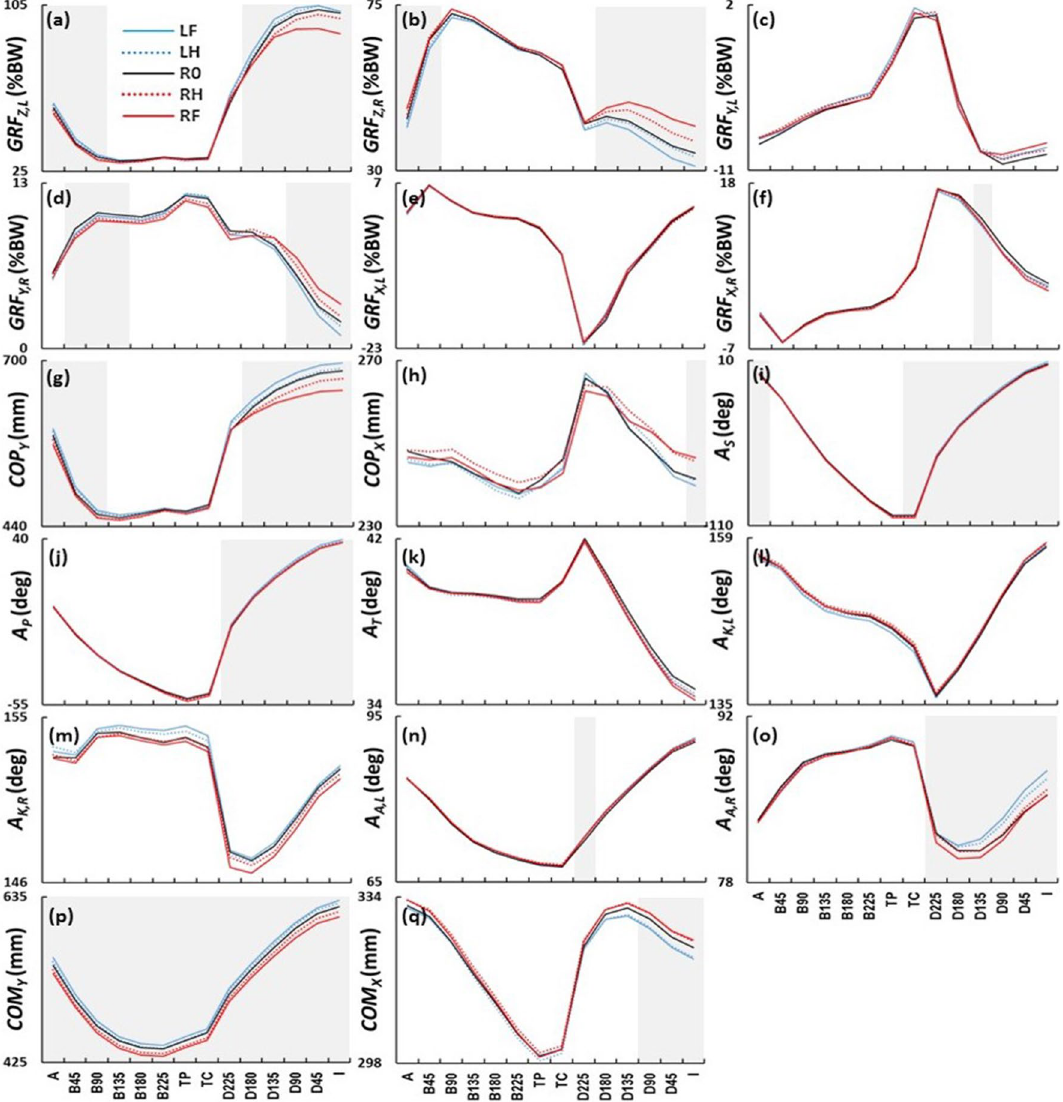
Figure 3. SPM results of the effect of mediolateral ball position on kinematic and kinetic variables during golf swing. LF, LH, R0, RH, and RF stand for left-full position (4.27 cm left from the reference), left-half position (2.14 cm left from the reference), reference ball position (i.e. preferred ball position), right-half position (2.14 cm right from the reference), and right-full position (4.27 cm right from the reference), respectively. The graphs show the mean trajectories across participants for (a) left foot vertical GRF ( GRF Z,L ) (+ : vertical), (b) right foot vertical GRF ( GRF Z,R ) (+ : vertical), (c) left foot mediolateral GRF ( GRF Y,L ) (+ : lateral), (d) right foot mediolateral GRF ( GRF Y,R ) (+ : medial), (e) left foot anteroposterior GRF ( GRF X,L ) (+ : anterior), (f) right foot anteroposterior GRF ( GRF X,R ) (+ : anterior), (g) mediolateral centre of pressure ( COP Y ) (+ : towards the target), (h) anteroposterior centre of pressure ( COP X ) (+ : anterior), (i) shoulder angle ( A S ) (+ : open), (j) pelvis angle ( A P ) (+ : open), (k) trunk angle ( A T ) (+ : flexion), (l) left knee angle ( A K.L ) (+ : extension), (m) right knee angle ( A K,R ) (+ : extension), (n) left ankle angle ( A A,L ) (+ : extension), (o) right ankle angle ( A A,R ) (+ : extension), (p) mediolateral centre of mass ( COM Y ) (+ : towards the target), and (q) anteroposterior centre of mass ( COM X ) (+ : anterior). The grey area indicates a significant difference between ball positions. The horizontal axes show 14 swing events (see Fig. 2). %BW percentage of body